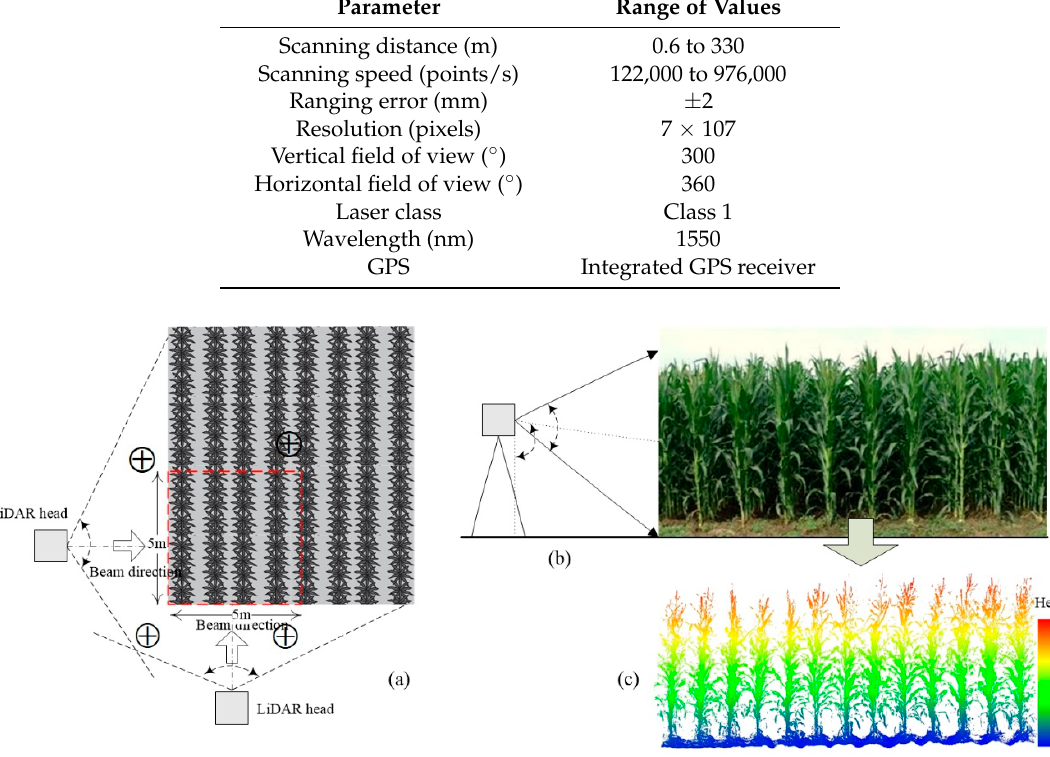
Figure 3. Top view ( a ) and side view ( b ) of the laser scanning scheme for the corn canopy, and ( c ) sample image of the scanning data for a corn canopy.